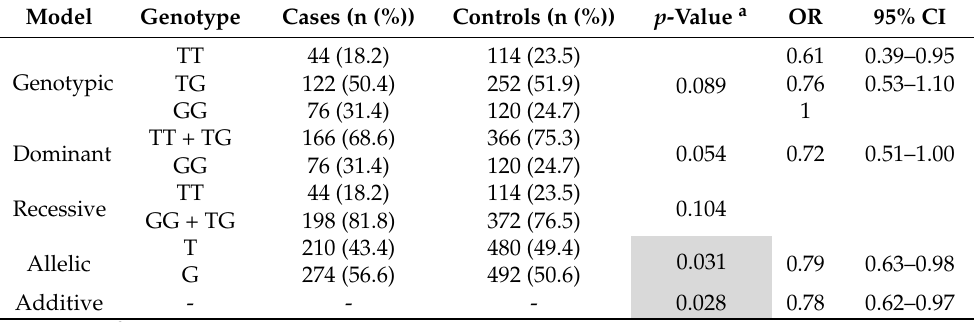
Table 2. Influence of GC rs7041 SNP on risk of HBP.